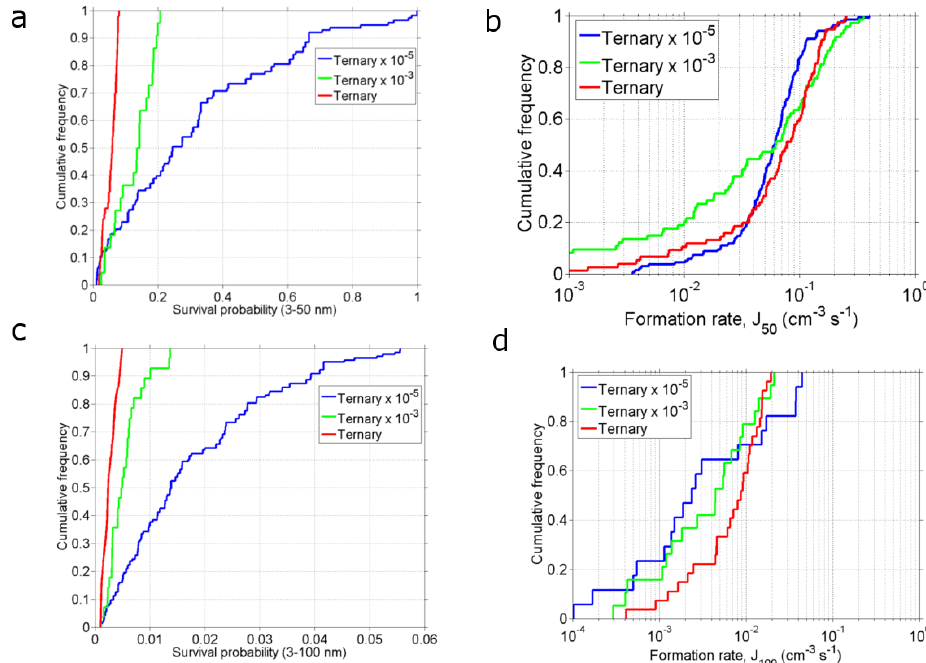
Figure 9. Cumulative distribution functions of nucleation event parameters at Hyytiälä. Red curves represent the original ternary simulation (Napari et al., 2002). Green curves represent ternary nucleation with a 10 − 3 tuning factor. Blue curves represent ternary nucleation with a 10 − 5 tuning factor. (a) Survival probability to 50nm, SP 3 − 50 (b) 50nm particle formation rate, J 50 (cm − 3 s − 1 ) ; (c) Survival probability to 100nm, SP 3 − 100 ; (d) 100nm particle formation rate, J 100 (cm − 3 s − 1